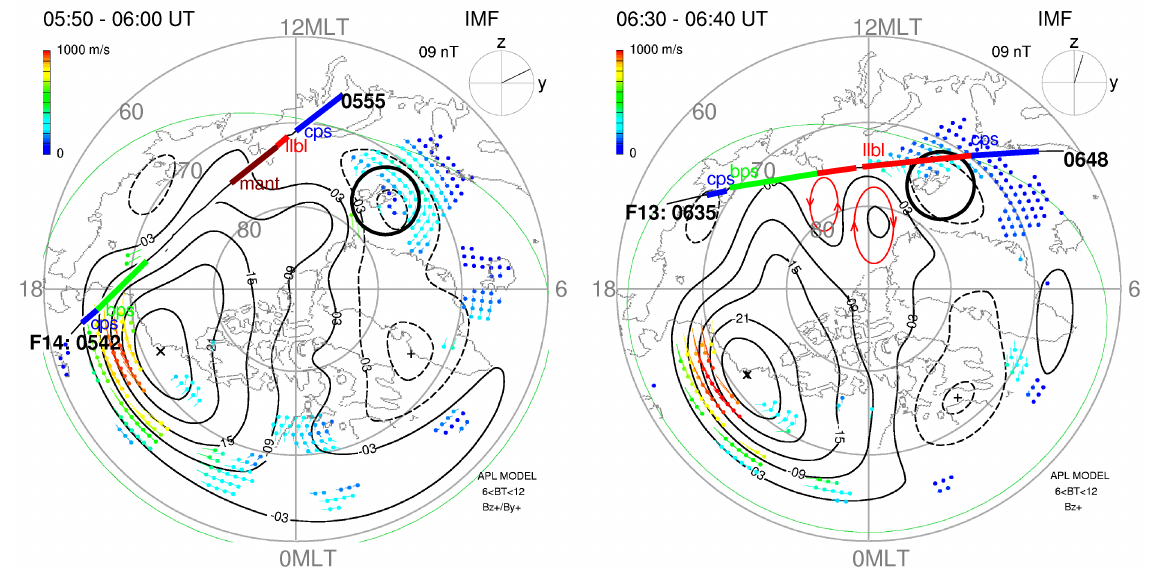
Fig. 3. Global convection patterns averaged over 10 min for the B y -dominated (left panel) and strongly northward (right panel) IMF conditions. The solid (dotted) contours are associated with positive (negative) values of the electrostatic potential, and the contour interval is 6kV. Velocity vectors implied by the fitting are plotted at points where constraining velocity data were provided by either measurements or the model. Trajectories of the DMSP satellites and the precipitations from different magnetospheric regions are shown in the same way as in Fig. 2. The polar cap convection cells are represented by red ellipses in the right